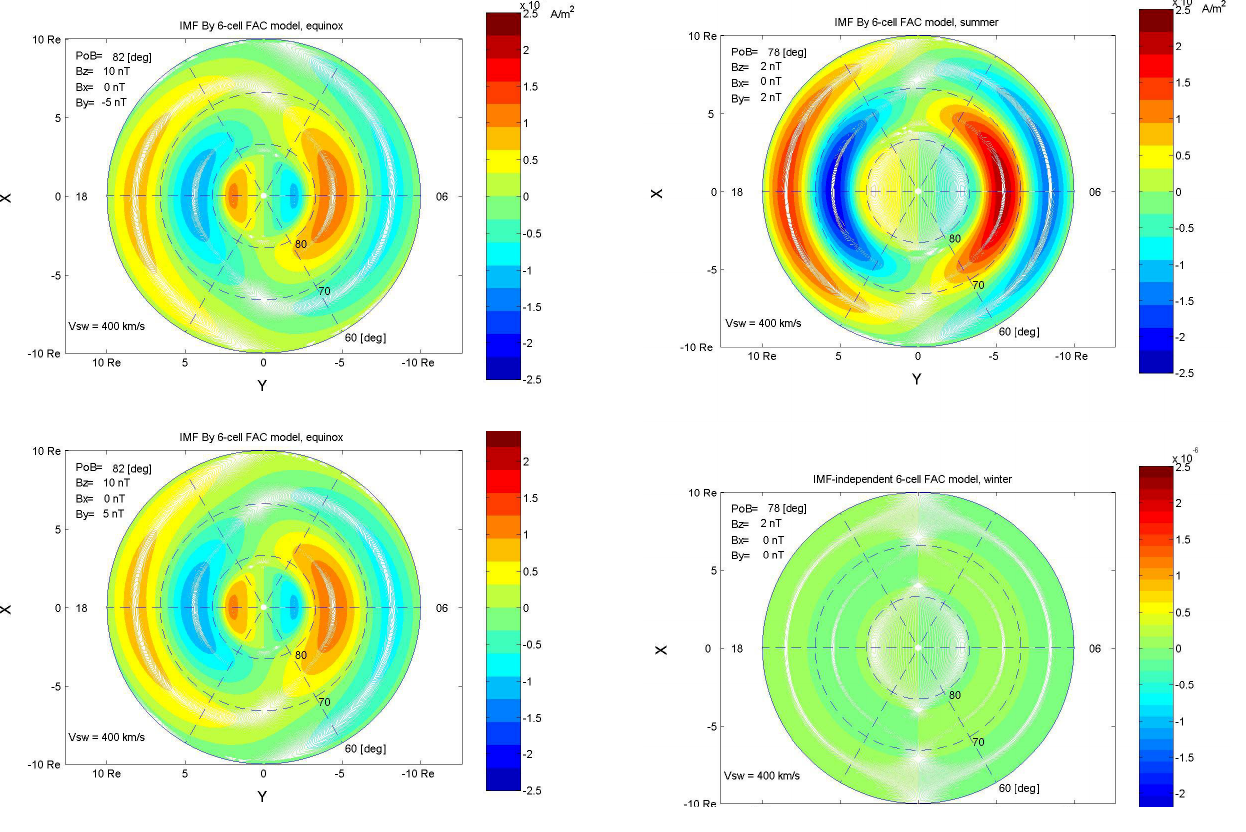
Fig. 5. Figure 5a, b characterize the six-cell FAC structure under summer and winter conditions. In comparison to equinox condi- tions (not shown) the FAC intensity in summer becomes 1.6 times greater. Under winter conditions the FAC intensity is, however, ap- proximately three times less than in